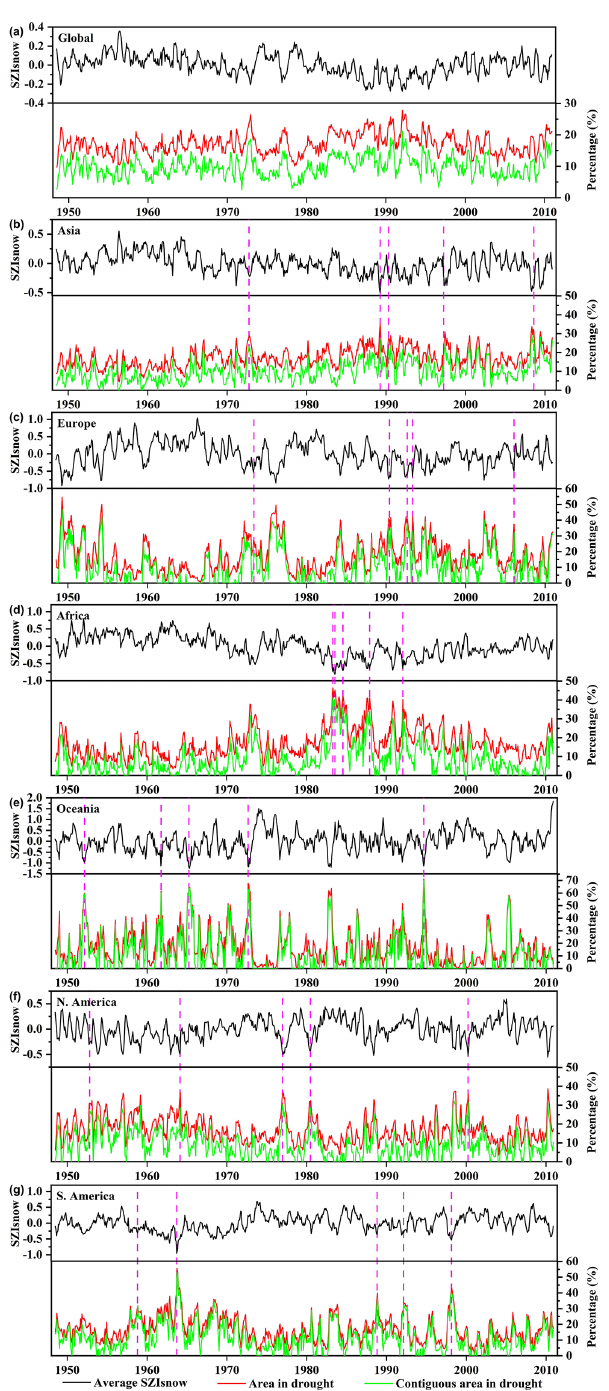
Figure 9. Temporal variation in monthly area-averaged SZI snow (black lines), the area in drought (pixels with SZI snow < − 1, red lines), and contiguous area in drought (green lines) for the world, Asia, Europe, Africa, Oceania, North America, and South America. The vertical pink dashed lines mark the top five major large-scale drought events in each